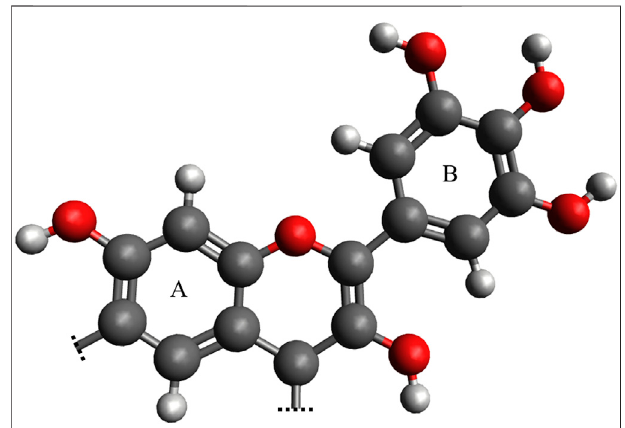
FIGURE 2 | Chemical structure of the fl avonoid